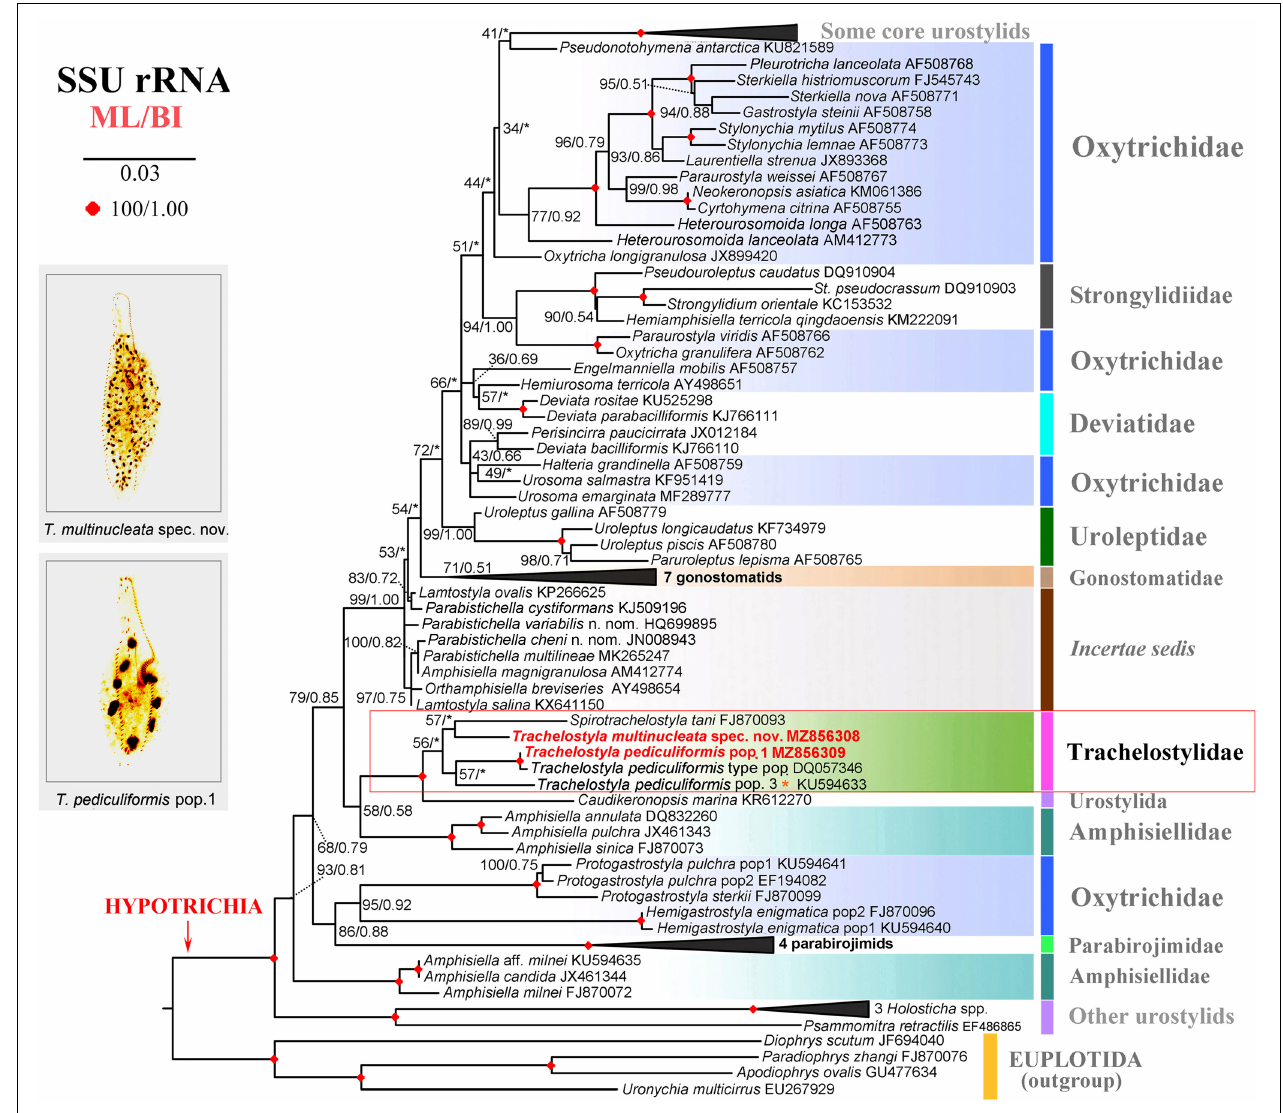
FIGURE 8 | Maximum likelihood tree inferred from SSU rDNA sequences, showing the phylogenetic positions of Trachelostyla multinucleata spec. nov. and Trachelostyla pediculiformis pop. 1 (indicated by bold face and red color). Numbers near branches denote bootstrap values for maximum likelihood (ML) and posterior probabilities for Bayesian inference (BI). Black asterisks indicate the disagreement between ML and BI trees. GenBank accession numbers are provided after species names. Trachelostyla pediculiformis pop. 3 marked by red asterisk was very likely misidentified by Huang et al. (2016). Scale bar corresponds to three substitutions per 100 nucleotide